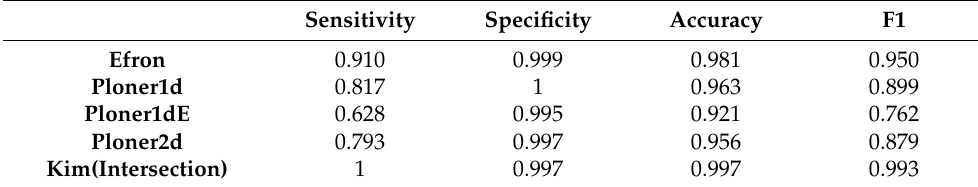
Table 6. Scale change scenario (two-sided alternative): Performance measures when k = 4 and cutoff =